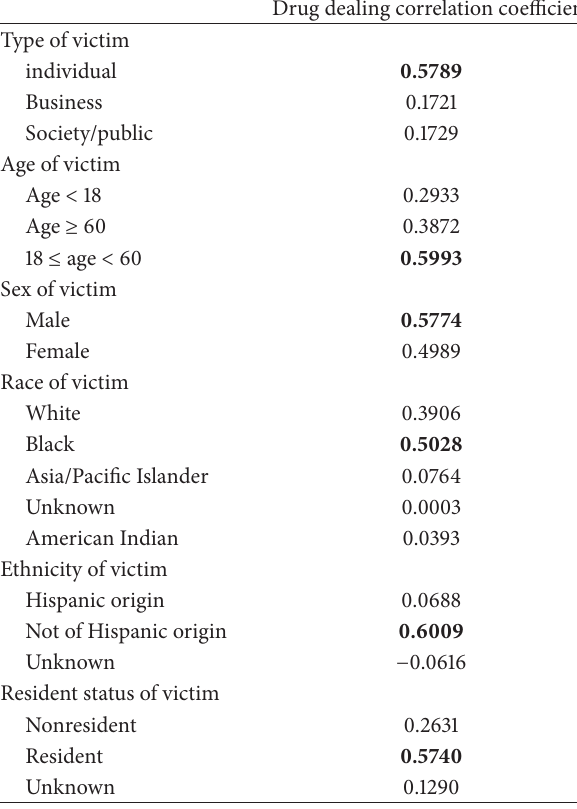
Table 5: Drug dealing correlation with other crime parameters related to victim.